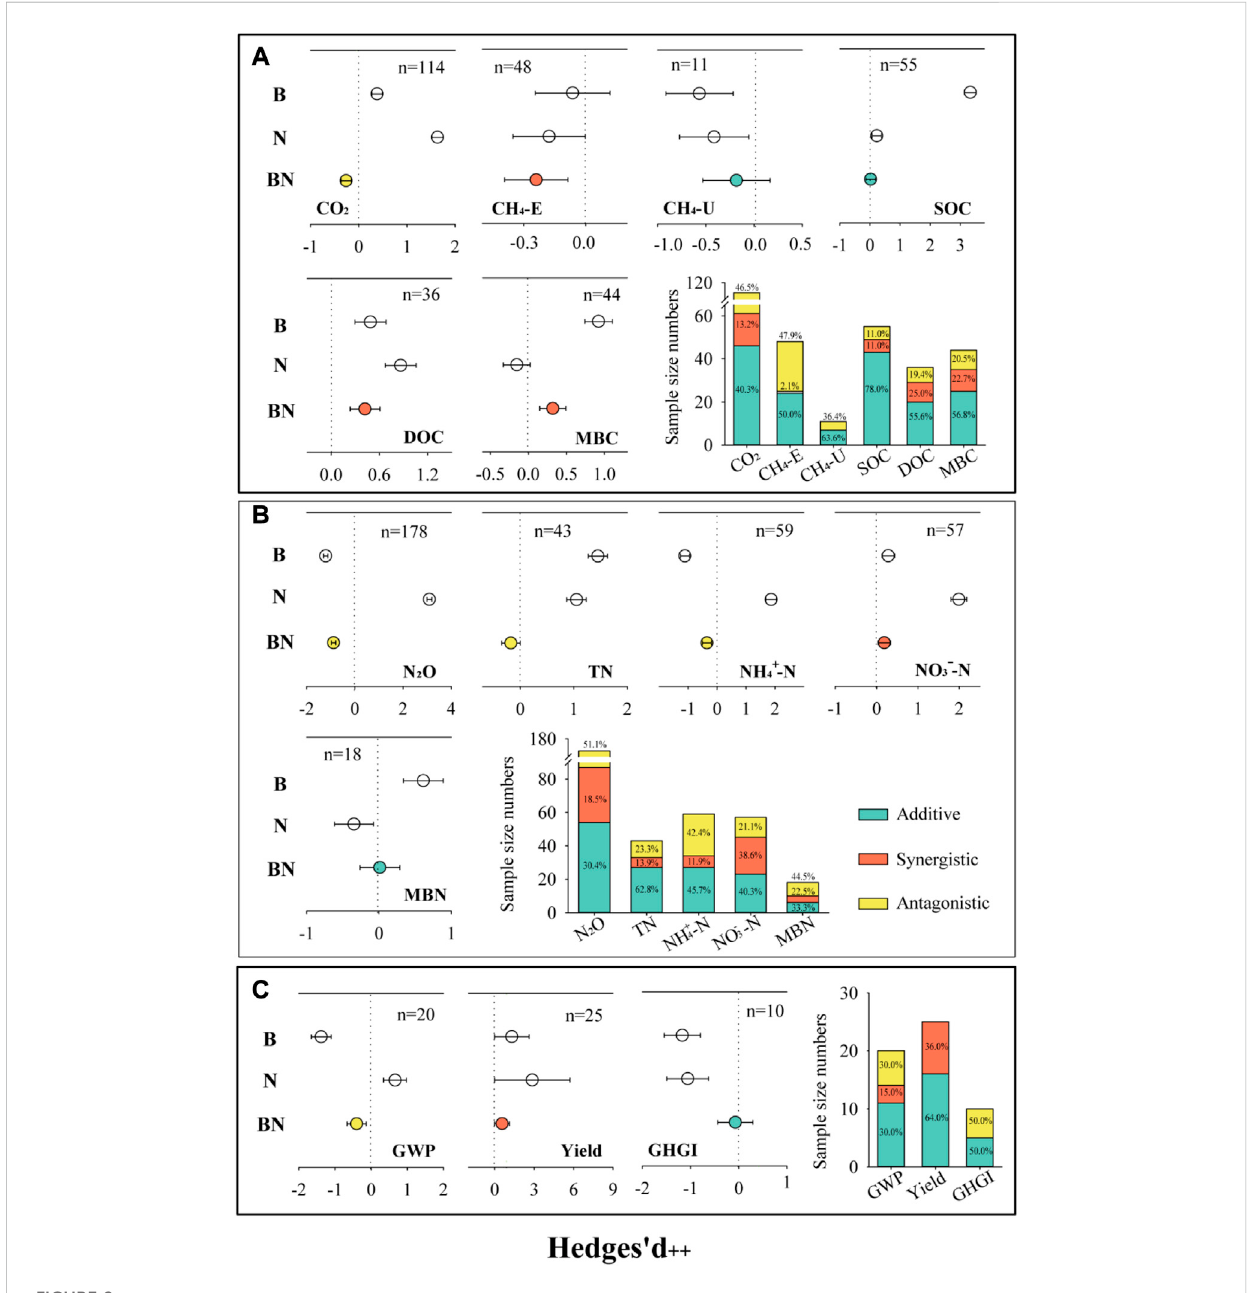
FIGURE 2 Effects of biochar-N interactions on soil carbon cycle (A) , N cycle (B) and GHGI (C) .